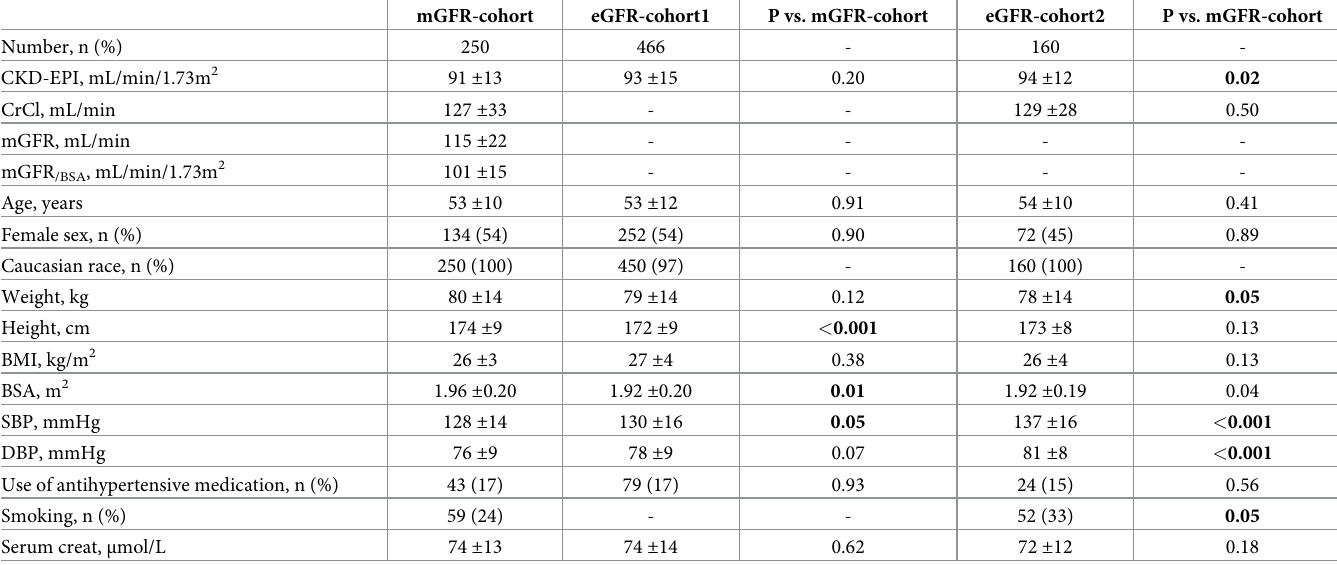
Table 2. Characteristics of the living kidney donors during